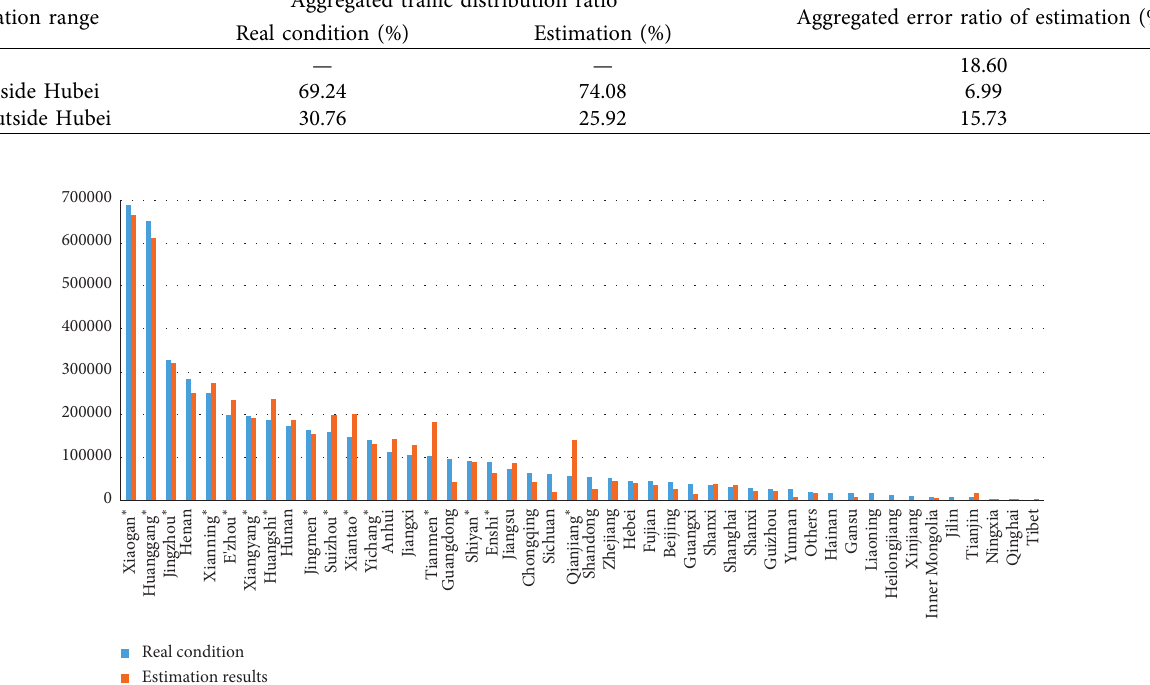
Figure 3: Traffic flow distribution results for the real condition. Table 8: Estimation of the number of incidence cases and the error of estimation for cities inside the province of